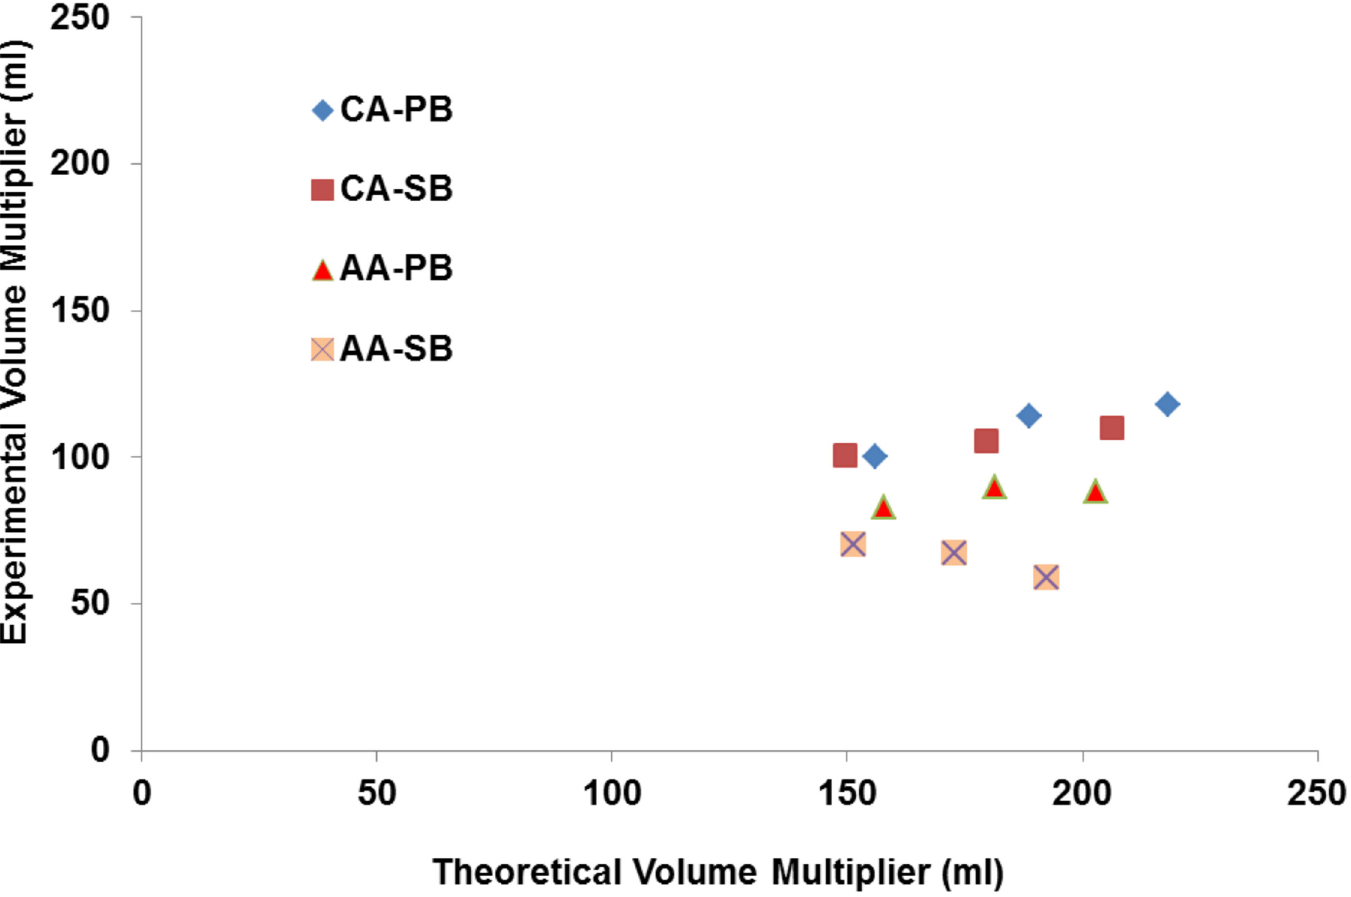
Fig 3. Measured volume multiplier after 15 minutes compared with the expected stoichiometric values. The points in the CA series, from left to right, represent 40%, 50% and 60% acid concentrations, respectively. The points in the AA series, from left to right, represent 50%, 60% and 70% acid concentrations,